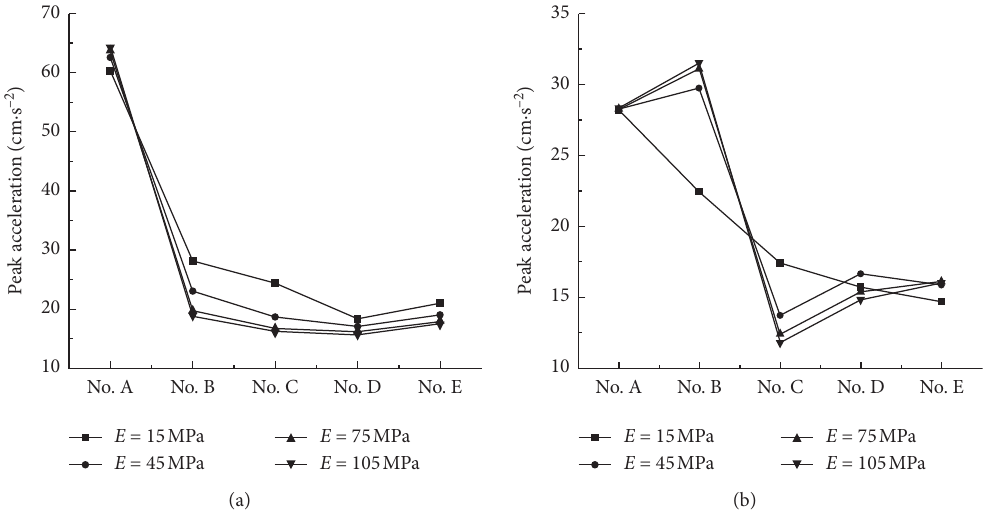
Figure 16: Influence of elastic modulus of the third terrace on vibration. (a) Horizontal direction. (b) Vertical